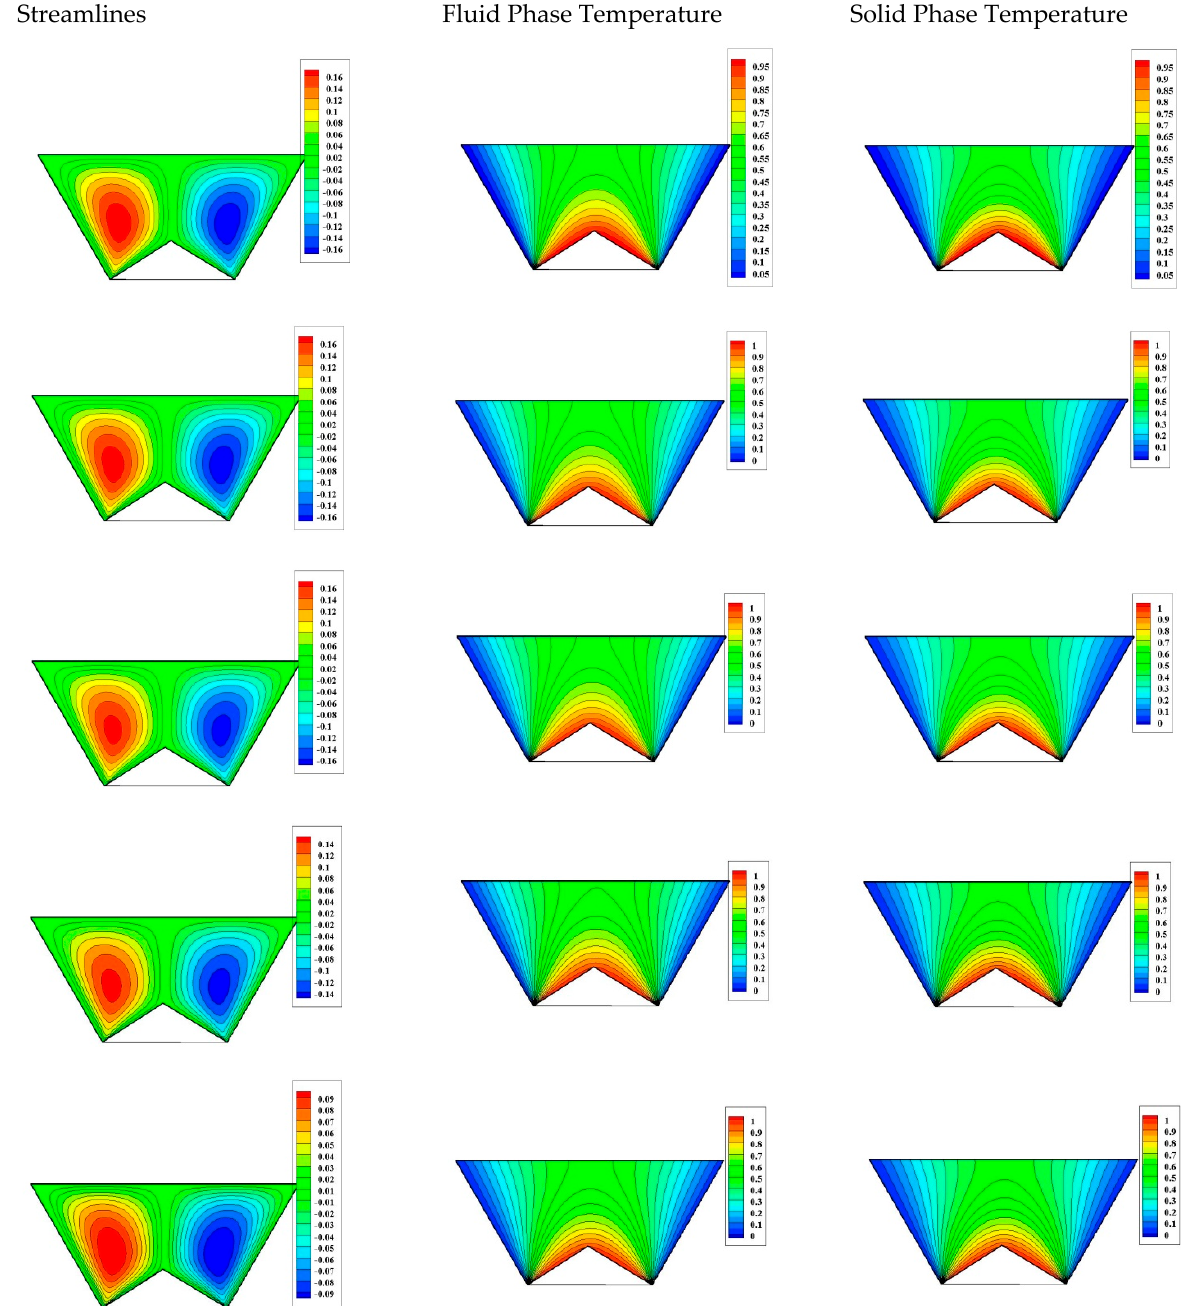
Figure 6. Features of the streamlines and temperature distribution for the fluid phase and porous phase for the variation of the Hartmann number Ha ( Ha = 0,15,25,50,100) at Ra = 10 5 , H = 0.1, φ Al = φ Cu = 1%, Φ = π , γ = 0. Figure 7 represents features of the local entropy generation due to the fluid friction and local Be for the variation of the Hartmann number Ha ( Ha = 0, 15, 25, 50, 100) at Ra = 10 5 , H = 0.1, φ Al = φ Cu = 1%, Φ = π , γ = 0. The graph shows that S f decreases as 𝐻𝑎